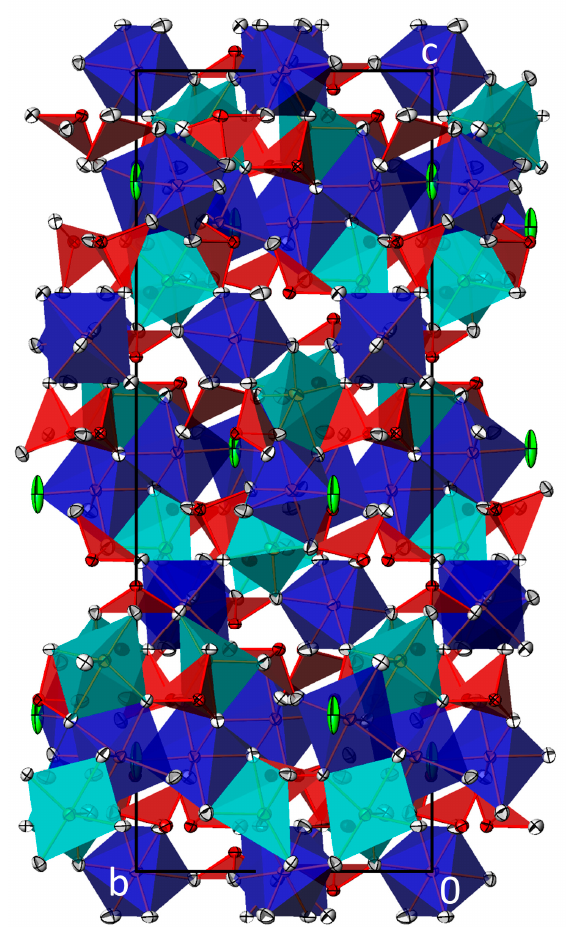
Figure 4. The crystal structures of Co 15 (TeO 3 ) 14 (OH) 2 in a projection along [100]. [CoO 6 ] and [CoO 5 OH] octahedra (Co1, Co3) are dark blue, [CoO 5 ] polyhedra (Co2) are turquoise and [TeO 3 ] polyhedra are red; the O8 atoms associated with the OH function are emphasized in green. Displacement ellipsoids are as in Figure 2. The quantitative structural comparison between Co 15 (TeO 3 ) 14 (OH) 2 , as the reference structure, with isotypic Mn 15 (TeO 3 ) 14 (OH) 2 and Co 15 (TeO 3 ) 14 F 2 , is provided in Table 3. Atomic displacements for atom pairs in the structures, numerical values for the degree of lattice distortion (S), the arithmetic mean ( d av ) of all distances and the measure of similarity ( ∆ ) are compiled. On the whole, the absolute displacements for atom pairs are greater with respect to Mn 15 (TeO 3 ) 14 (OH) 2 than to Co 15 (TeO 3 ) 14 F 2 . Except for the OH group, which is substituted with an F atom, all atoms in Co 15 (TeO 3 ) 14 F 2 remain the same, whereas all transition metal atoms are replaced with respect to Mn 15 (TeO 3 ) 14 (OH) 2 . In the latter case, the larger ionic radii of Mn II (0.75 Å for a coordination number of 5, 0.83 Å for a coordination number of 6 compared to Co II with 0.67 and 0.745 Å, respectively [35]) are responsible for the higher atomic displacements, and consequently cause higher numbers for S and d av , and therefore a structure with a lower similarity. However, in both cases, the highest displacement is observed for atom O8, which is associated with the OH group. The correspondent functionality as a donor for hydrogen bonding interactions, despite being weak in the present case, strongly influences its displacement in the isotypic structures. On the one hand, the replacement of OH through F leads to the disappearance of hydrogen bonding interactions. On the other hand, the larger Mn II ions evoke an expansion of the entire structure, which also has an impact on the hydrogen bonding scheme with modified donor ··· acceptor